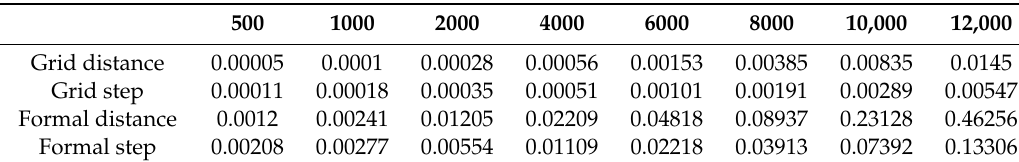
Table 5. Routing planning results (ms).